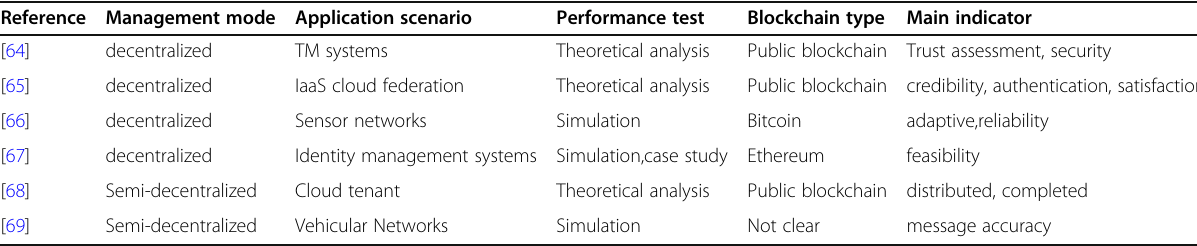
Table 1 Comparison of the applied methodology Reference Management mode Application scenario